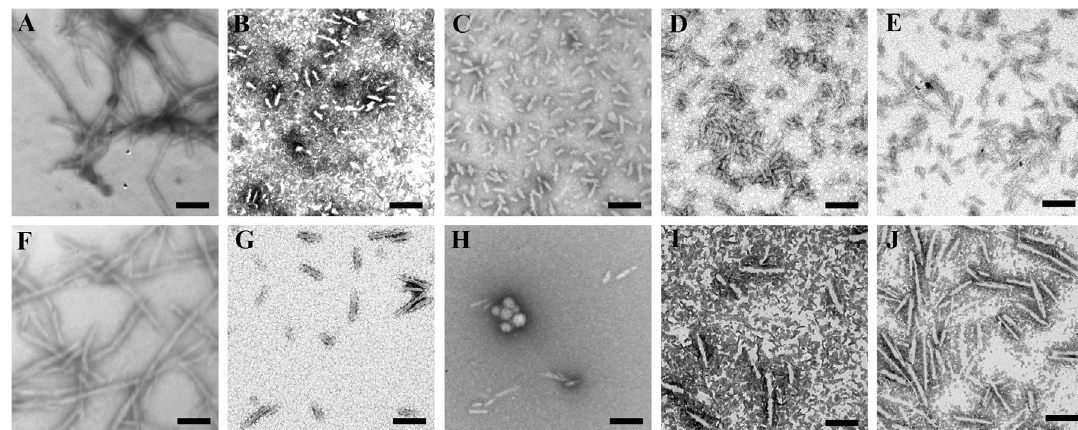
Figure 3. Transmission electron micrographs of human/rabbit chimera PrP samples at physiological pH after incubation under different conditions. Human (A–E) and rabbit (F–J) chimera PrP samples were incubated for 10 h (A) or 8 h (F) or 4 h (D, G, and I) or 3 h (B, E, H, and J) or 2 h (C) in the absence of a crowding agent (A and F) and in the presence of 150 g/l Ficoll 70 (B and G) or 200 g/l Ficoll 70 (C and H) or 100 g/ l Ficoll 400 (D and I) or 150 g/l Ficoll 400 (E and J), respectively. We used a 2% (w/v) uranyl acetate solution to stain the fibrils negatively. The scale bars represent 200 nm.